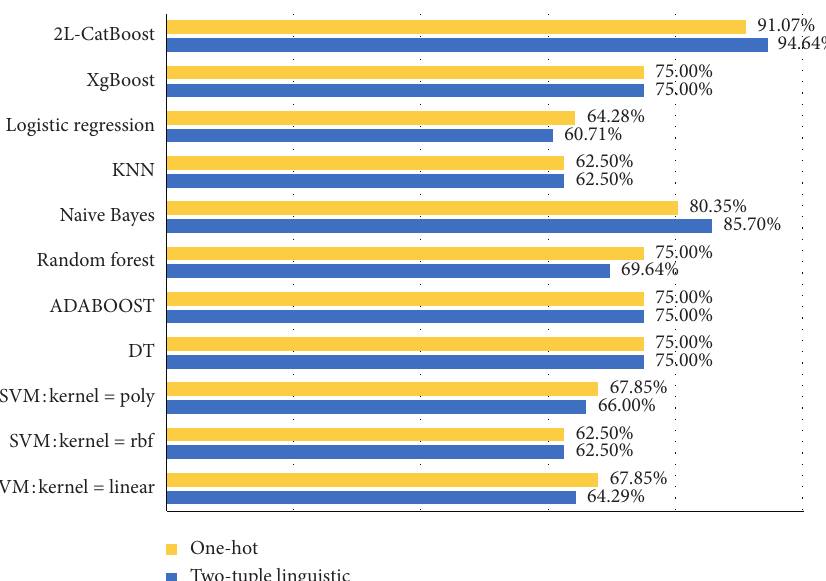
Figure 5: Classification accuracy of different classifiers.